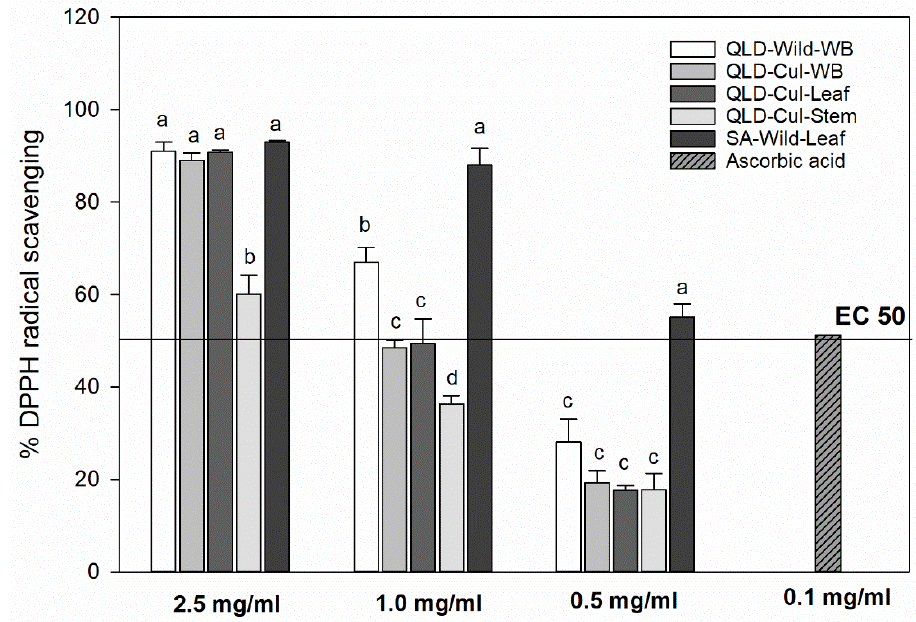
Figure 5. 2,2-diphenyl-1-picrylhydrazyl (DPPH) radical-scavenging capacity of P. angustifolium extracts. EC 50 value is the amount/concentration of the sample extract or ascorbic acid necessary to scavenge/reduce the initial DPPH radical concentration by 50% (50% effective concentration). Different letters within individual extract indicate significant differences at α = 0.05.